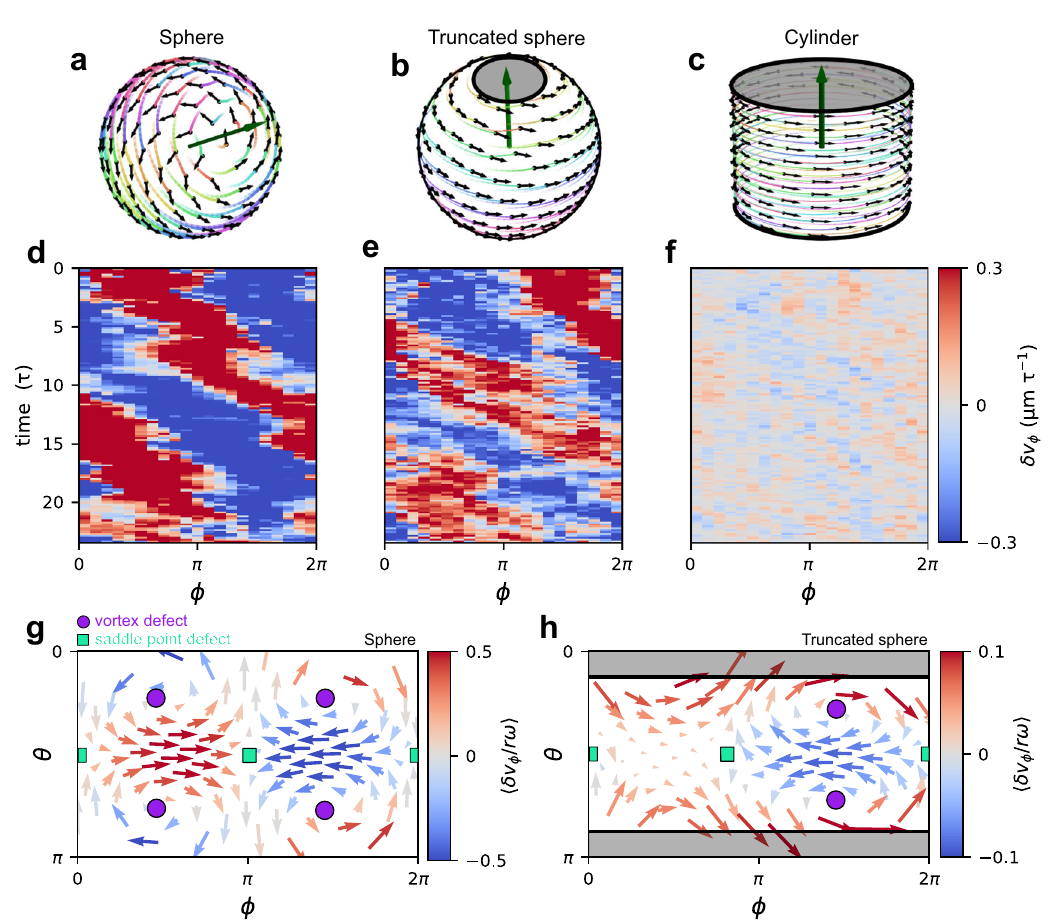
Fig. 5 | Velocity waves on different geometries. a – c Snapshots of the dynamics predicted by our model of active particles on a sphere in a low-noise rotation regime( a ),onatruncatedspherewithlow-noiserotations( b ),andonacylinder( c ). d – f Representative kymographs δ v ϕ ϕ , t ð Þ of the equatorial azimuthal velocity fl uctuations predicted by our model for the three different geometries considered